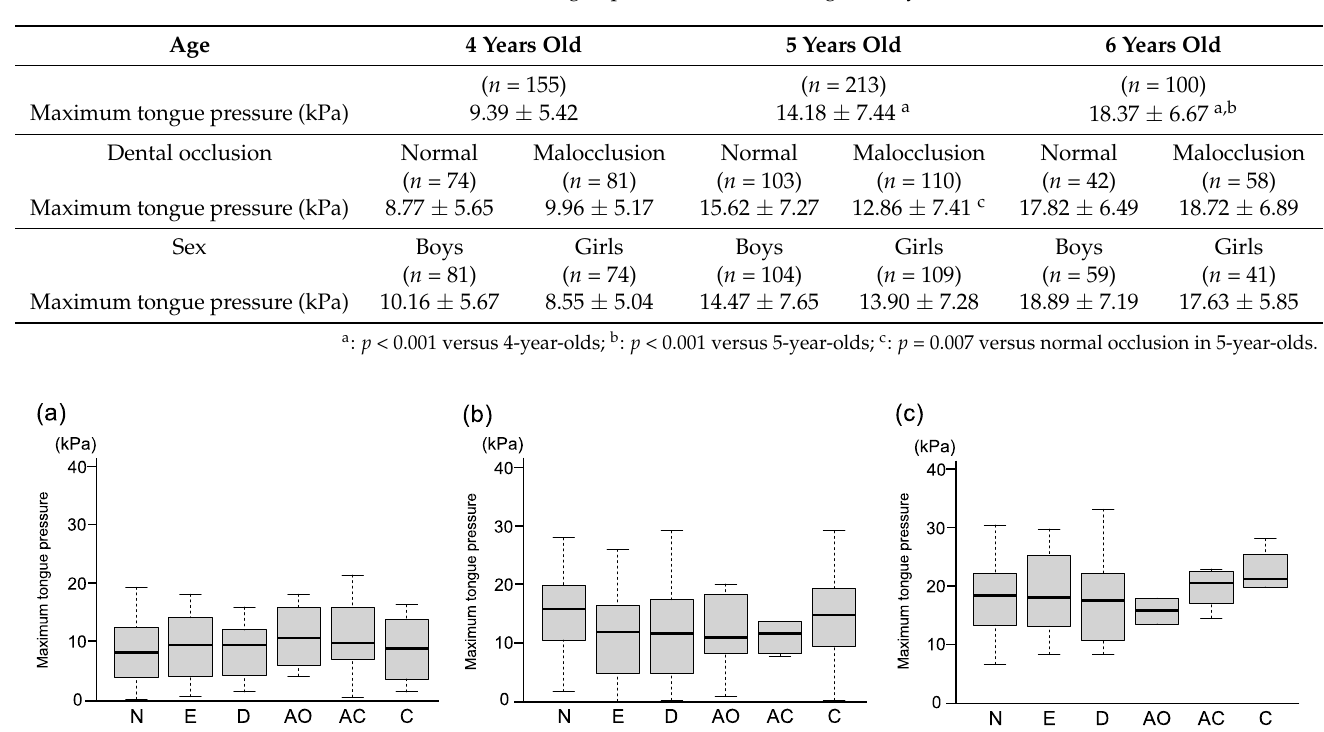
Table 2. Maximum tongue pressure in children aged 4–6 years.